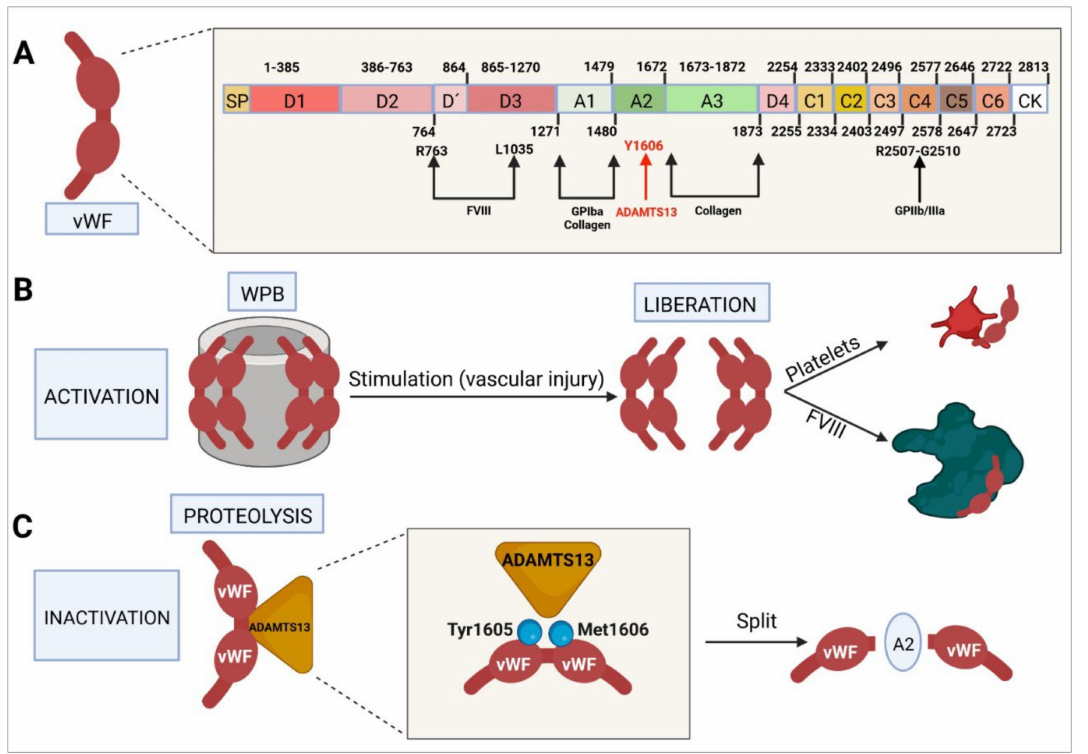
Figure 3. Molecular characteristics of von Willebrand factor. (A) Domain-based structure of the protein, sites at which it interacts with other factors and cofactors, and activation and inactivation sites. (B) WPB-mediated activation and final interaction of vWF with platelets and FVIII. (C) Proteolytic inactivation resulting from interaction with ADAMTS13 and cleavage at the level of the A2 domain. vWF, von Willebrand factor; WPB, Weibel–Palade body; FVIII, factor